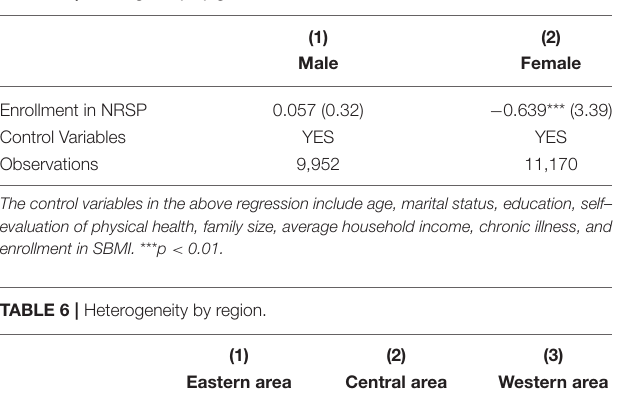
TABLE 4 | Regression results with instrumental variable. TABLE 5 | Heterogeneity by gender.